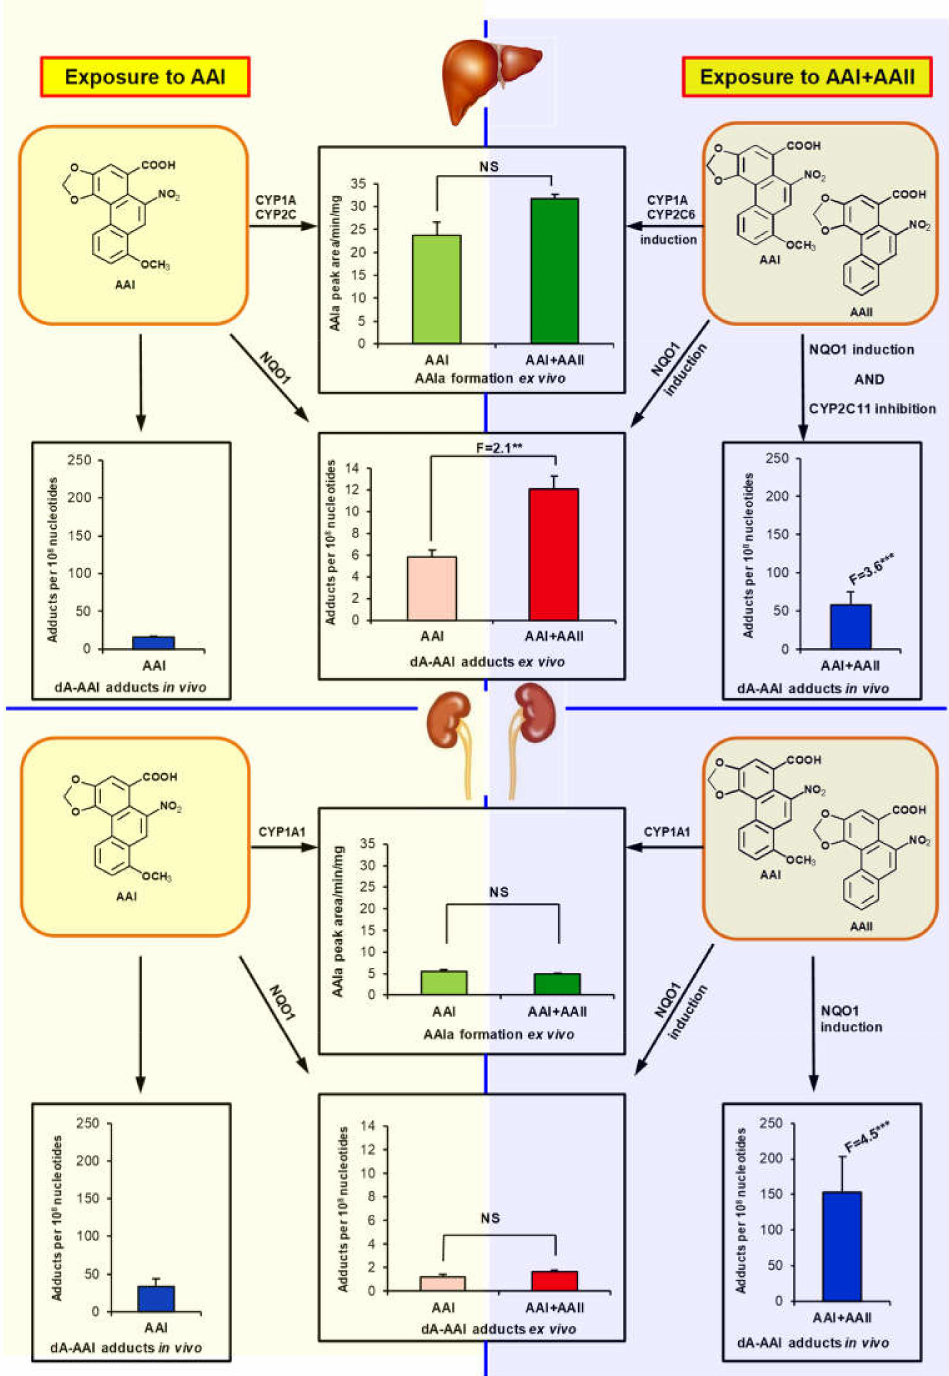
Figure 7. Schematic summary showing the effects of the presence of AAII on AAI-derived DNA adduct formation in the liver and kidneys in rats. Higher NQO1 induction in rats pre-treated with